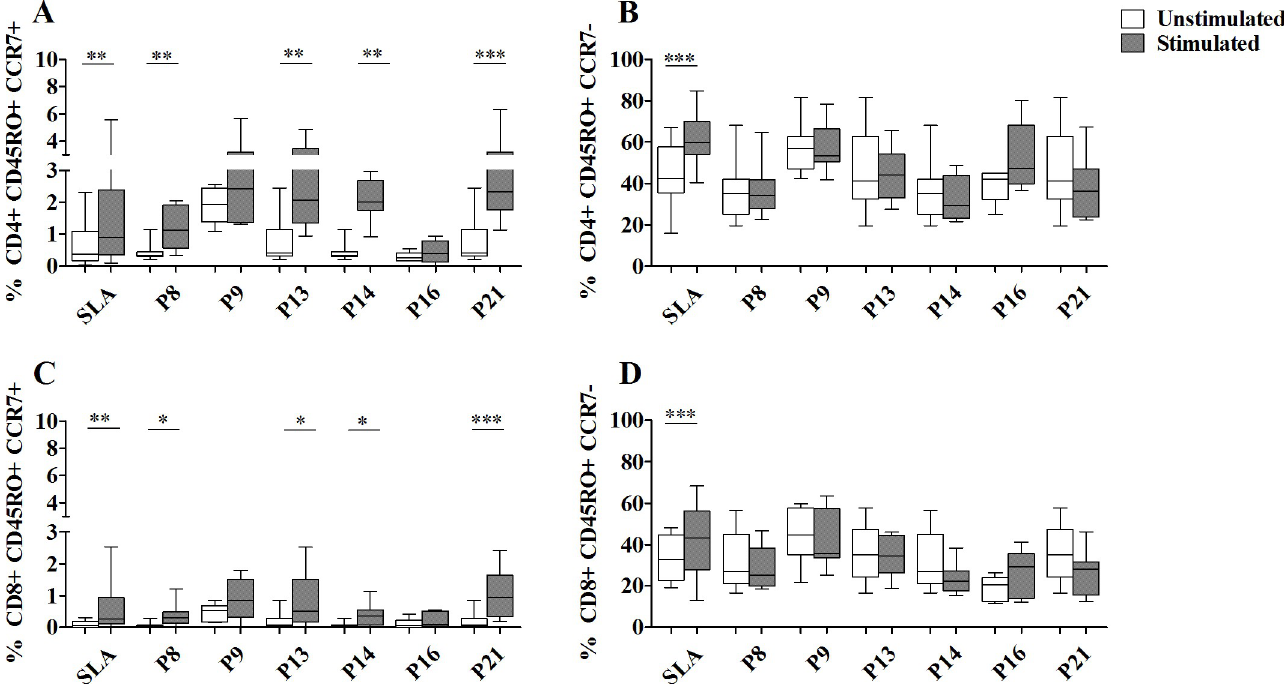
Fig 11. Phenotyping of multi-epitope peptide-specific CD4+ and CD8+ memory T cells. PBMC from cured CL subjects (N = 11), previously stimulated with selected peptide pools (1 μ M/peptide) for 10 days, were re-stimulated overnight with the same peptide pools (1 μ M/peptide) and with anti-CD49d/anti-CD28 antibodies (1 μ g/ml). The percentages of CD45RO+CCR7+CD4+ or CD8+ TCM ( A, C ) and, CD45RO+CCR7-CD4+ or CD8+ TEM ( B, D ), were analyzed by FlowJo software. PBMC stimulated with SLA (10 μ g/ml) for 5 days, were used as positive control. Statistical significance was assigned to a value of p < 0,05 ( � p < 0.05, �� p < 0.01, ��� p < 0.001).